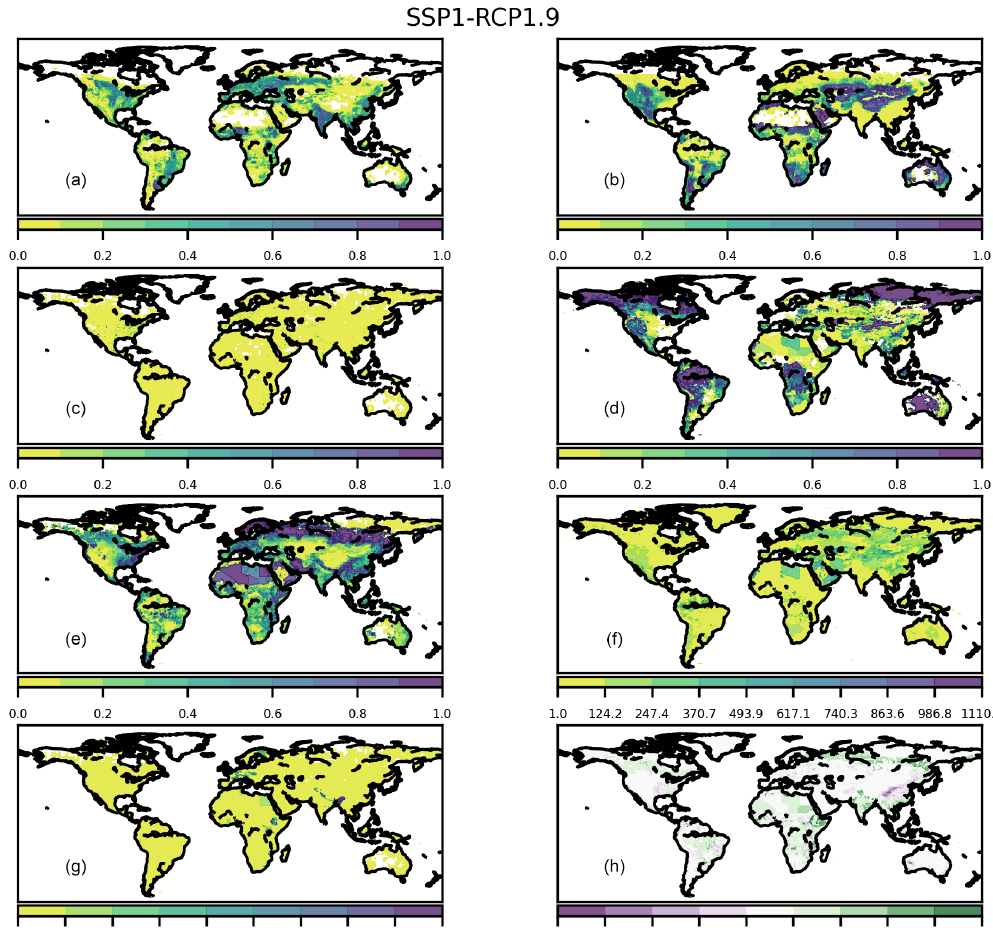
Figure A4. Maps for the year 2100 for the SSP1-RCP1.9 scenario showing the following: (a) the fraction of each grid cell occupied by cropland; (b) the fraction of each grid cell occupied by pasture; (c) the fraction of each grid cell occupied by urban land; (d) the fraction of each grid cell occupied by primary vegetation; (e) the fraction of each grid cell occupied by secondary vegetation; (f) the mean age (in years) of secondary lands in each half-degree grid cell; (g) the mean gross transitions (km 2 yr − 1 ) over a 20-year interval for each grid cell; and (h) the mean net transitions (km 2 yr − 1 ) over a 20-year interval for each grid